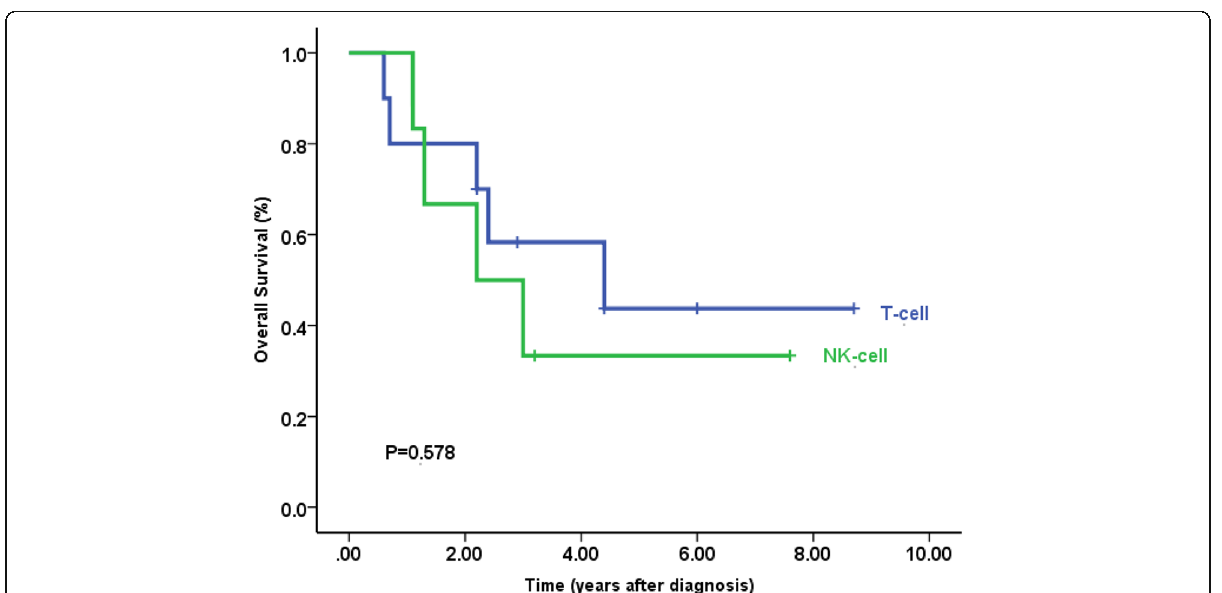
Fig. 4 Kaplan-Meier survival curves for patients with HV-LPD, categorized by a clinicopathological feature. Patients with T-cell lineage disease (CD4 and CD8) had similar clinical outcomes with those of NK-cell lineage disease for all the patients with or without the treatment ( n = 19, p = 0.578 for T-cell vs. NK-cell). Survival-time differences were analyzed with the log-rank